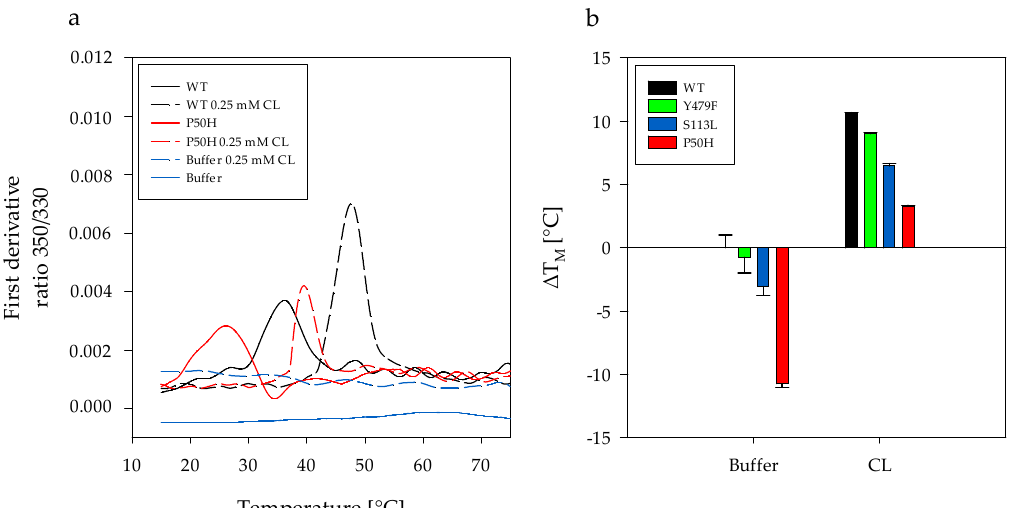
Figure 4. The effect of amino acid exchange and the addition of 0.25 mM CL on the stability of CPT II (1 mg/mL) assessed by nanoDSF. ( a ) The first derivatives of the transition curves resulting from the ratio 350/330 nm were plotted against the temperature. The T M values are derived from the maxima of the obtained curves. The black and red solid lines show the curves of WT and variant P50H measured in assay buffer. The black and red dashed lines show the results of WT and variant P50H measured in assay buffer with 0.25 mM CL. ( b ) The T M of WT (37 ◦ C) in buffer was used as reference value ( ∆ T M = 0 ◦ C) to determine the ∆ T M for the variants and the ∆ T M for WT and variants after the addition of 0.25 mM CL. Error bars are SD derived from three independent experiments. The significant differences of ∆ T M of WT and the variants between the different buffer composition as well as the statistical differences of T M between WT and the variants are indicated as p -values in Tables